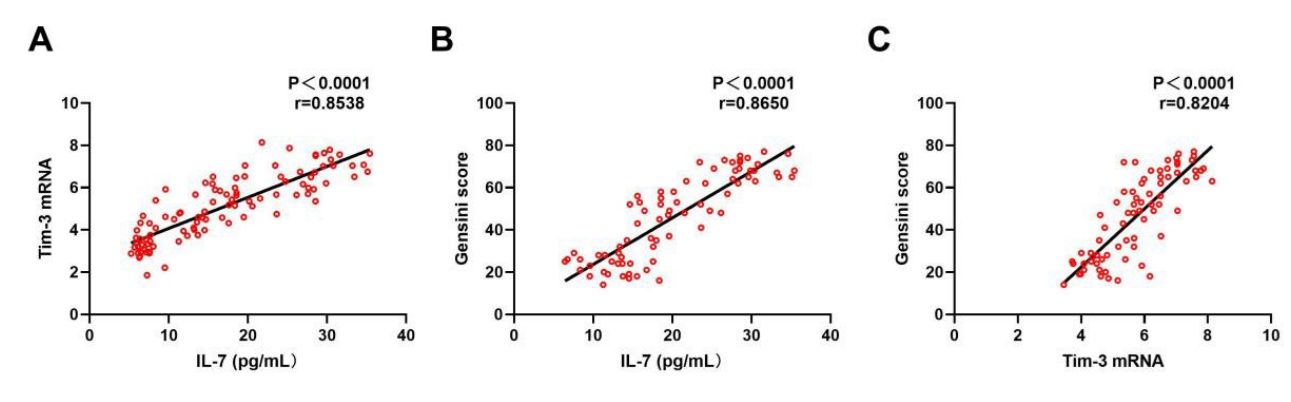
Fig. 3 - Correlation among the expression levels of Tim-3, IL-7 and the severity of disease. A-C: correlation among Tim-3, IL-7 and Gensini score was analyzed by Pearson correlation test.